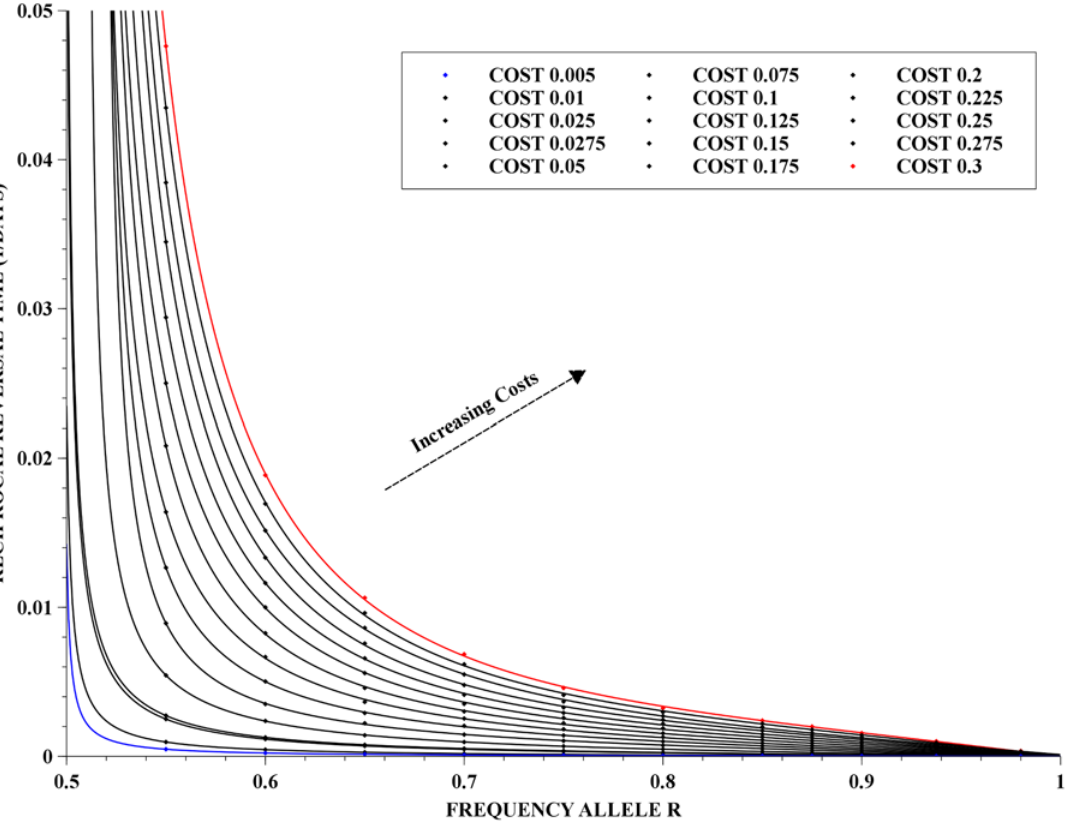
Fig 6. Reciprocal of reversal time as a function of initial frequency. Dependence of the reciprocal of reversal time on the initial frequency of the resistance allele together with rational least-squares fits for each set of points of the same cost. The costs vary from 0.005 up to 0.3 and the frequencies of the resistance allele were in the range of 55% to